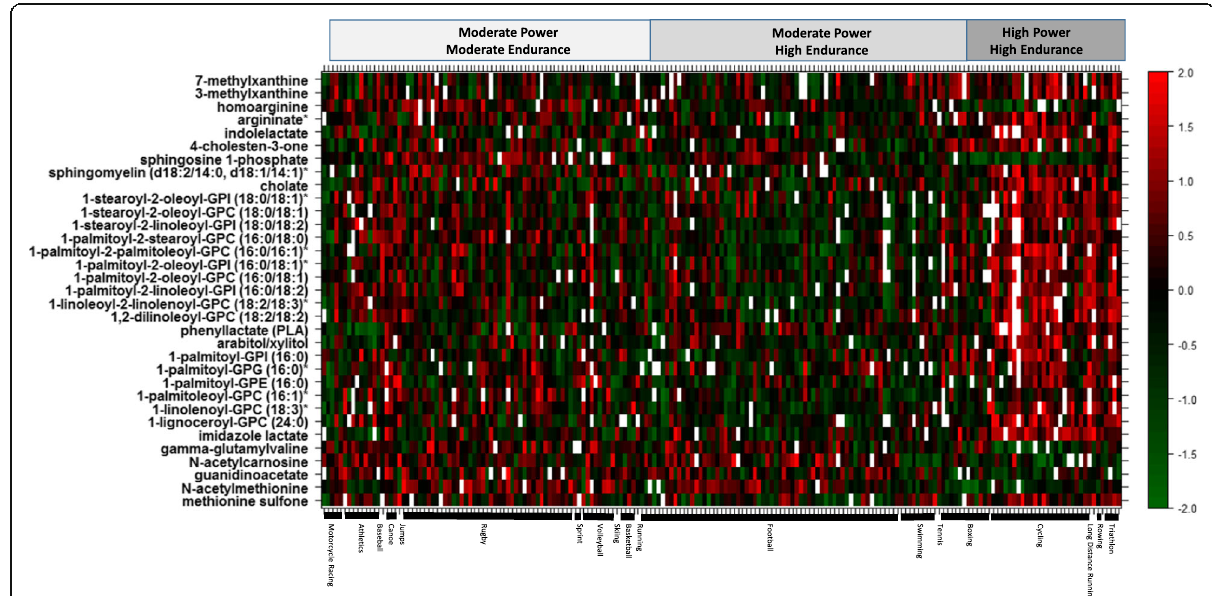
Fig. 5 Heatmap of metabolites significantly associated with high endurance from the linear model association analysis ( y -axis). Samples on x -axis were ordered by sports type and group. The color code denotes z -scaled values of metabolites after correction of confounders